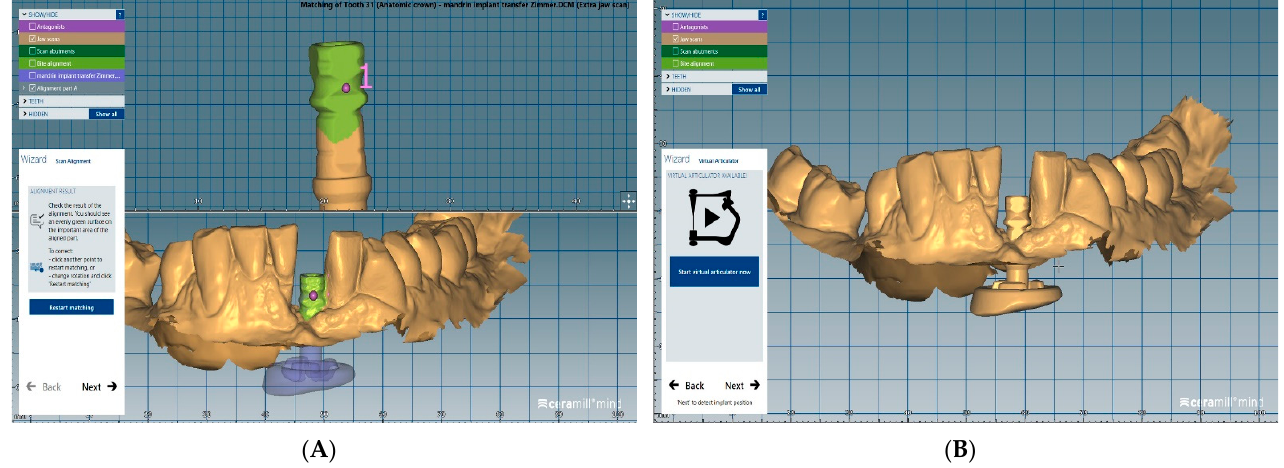
Figure 5. Analog transfer indexing: ( A ) index point; ( B ) superimposed STL files.